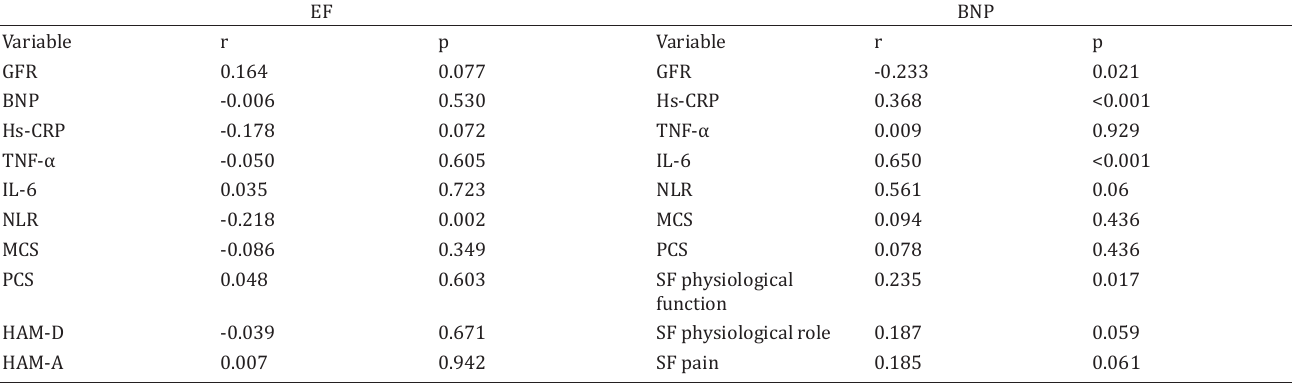
Correlation analysis between some parameters with EF and